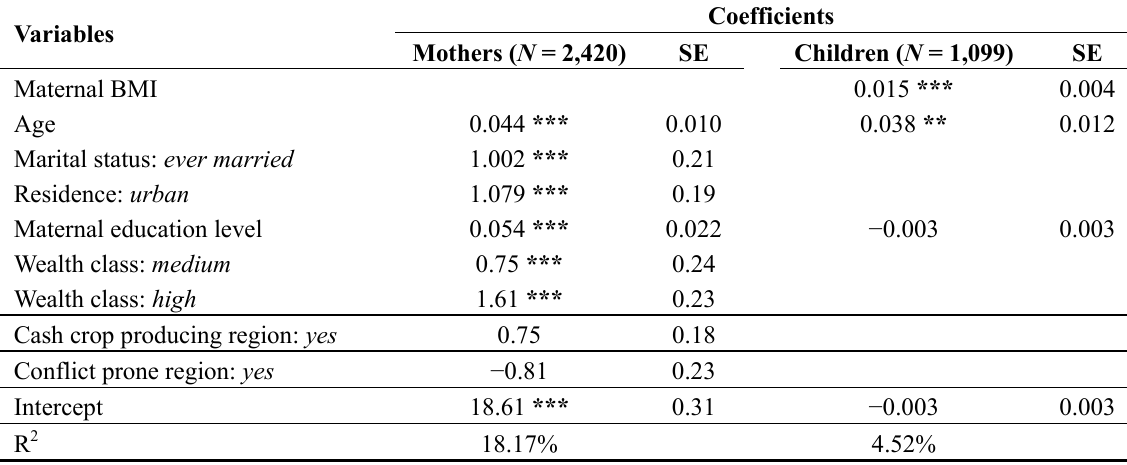
Table 2. Ordinary least square regression analysis relating socioeconomic and demographic risk factors for maternal and child weight. Reference categories are never married for marital status, no education for maternal education level, low wealth for wealth class, non-cash crop producing region , and non-conflict prone region . SE = standard error. ** p < 0.05, *** p < 0.001.